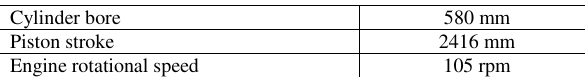
Table 1. Main data of the marine engine under consideration [14] Cylinder bore